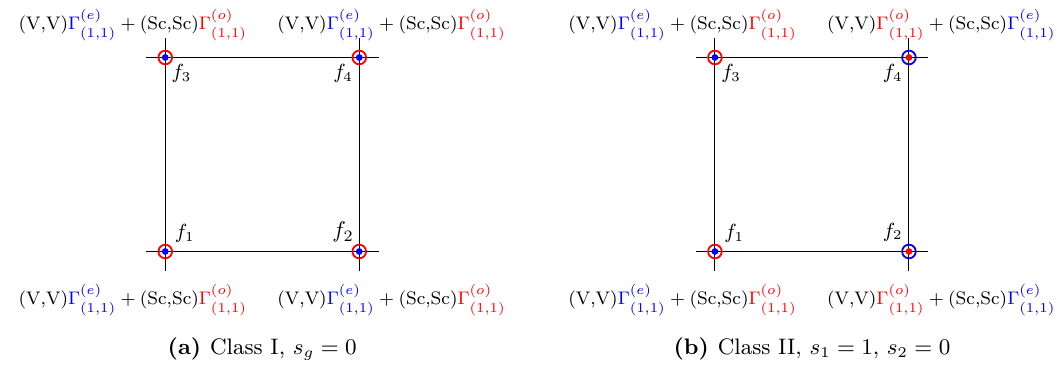
Figure 1. Lattices associated to (NS,NS) states sitting at fixed points in class I and class II Z 2 models. V and Sc refer respectively to vector and scalar SO (8)